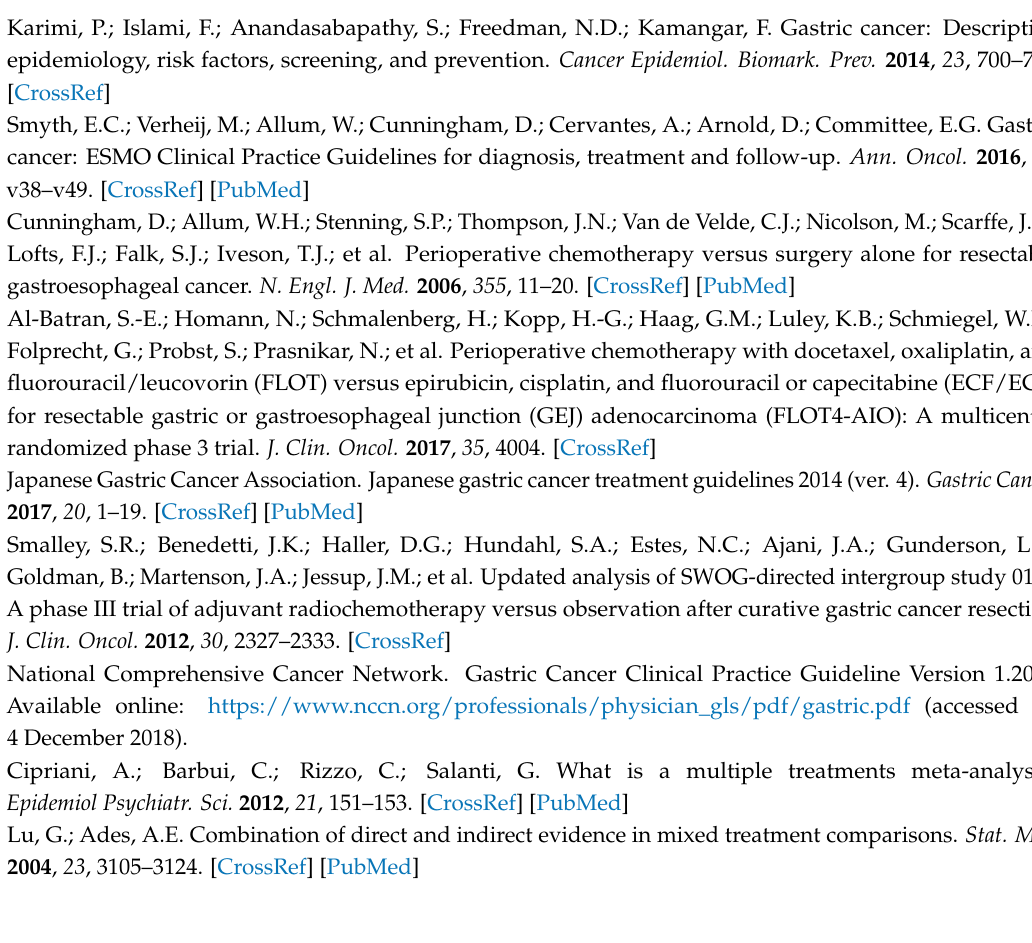
compared to surgery alone, Figure S2: Results for NMA-1 when neoadjuvant taxane and adjuvant taxane containing chemotherapy were separated from non-taxane containing neoadjuvant or adjuvant chemotherapy, Figure S3: Overall survival pair wise meta-analysis based on treatment strategy, Figure S4: Overall survival pair wise meta-analysis of adjuvant therapy for curatively resected gastric cancer, Figure S5: Disease free survival pair wise meta-analysis of adjuvant therapy for curatively resected gastric cancer, Figure S6: Overall survival risk of bias assessment for the treatment strategy NMA-1, Figure S7: Overall survival and disease free survival risk of bias assessment for the adjuvant therapy after curative resection NMA-2, Figure S8: Direct and combined hazard ratios for overall survival in the treatment strategy NMA-1, Figure S9: Direct and combined hazard ratios for overall survival in the adjuvant therapy after curative resection NMA-2, Figure S10: Direct and combined hazard ratios for disease free survival in the adjuvant therapy after curative resection NMA-2, Table S1: Grade 3-4 toxicity for the treatment strategy NMA-1, Table S2: Surgical mortality and morbidity for the treatment strategy NMA-1, Table S3: Grade 3-4 toxicity for the adjuvant therapy after curative resection